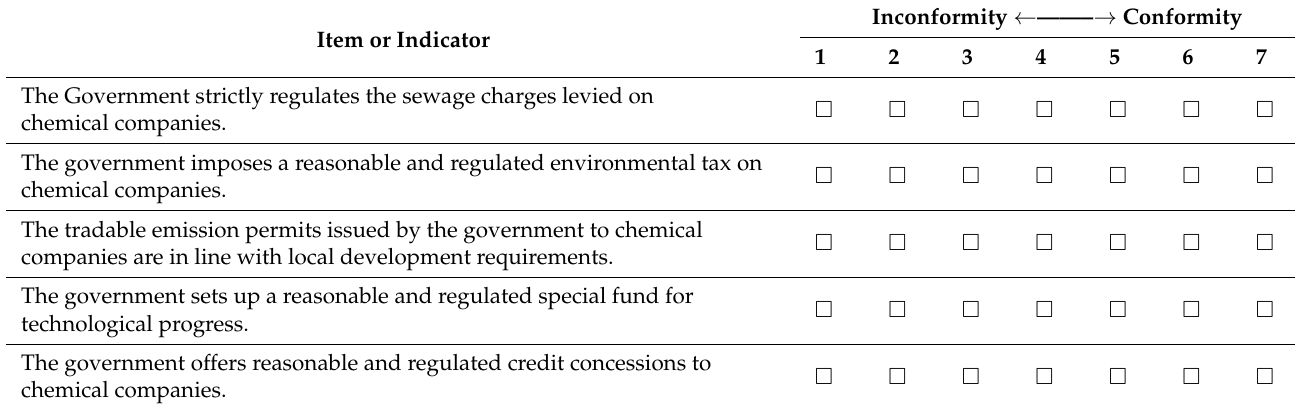
Table A3. Questionnaire for market-incentive environmental regulation.